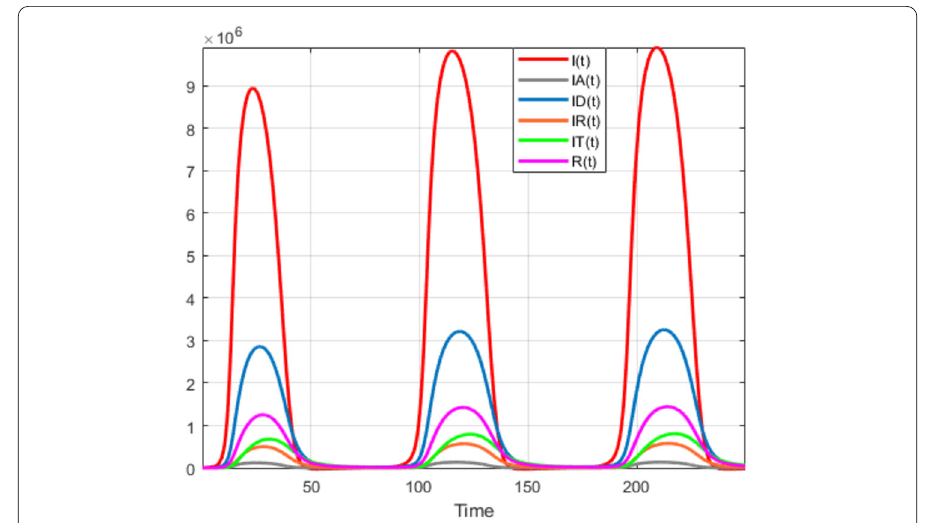
Figure 33 Numerical visualization of COVID-19 model for α = 0.82